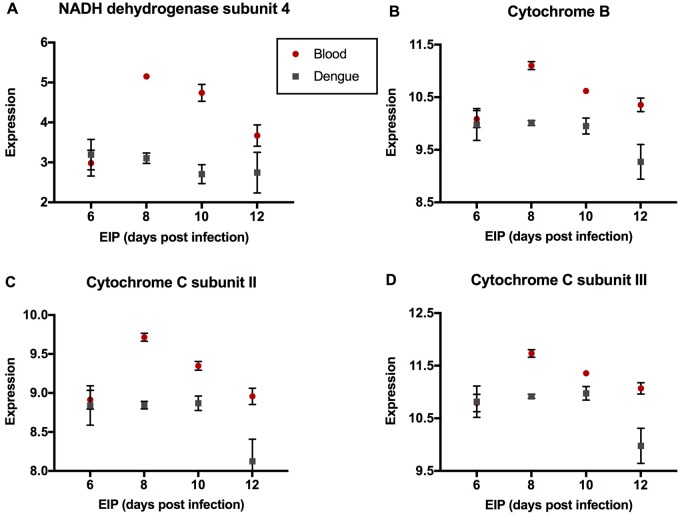
—Genes of enriched GO term GO:0022900 electron transport chain. Expression levels by EIP phenotype of (A) NADH dehydrogenase subunit 4, (B) cytochrome B, (C) cytochrome C subunit II, and (D) cytochrome C subunit III are shown. Expression levels were estimated from read counts from RNAseq data. Red circles depict mosquitoes fed with a naïve blood meal, while gray squares depict those fed with a viremic blood meal. Mean and SEM are shown in graphs (n = 6 per group per treatment).